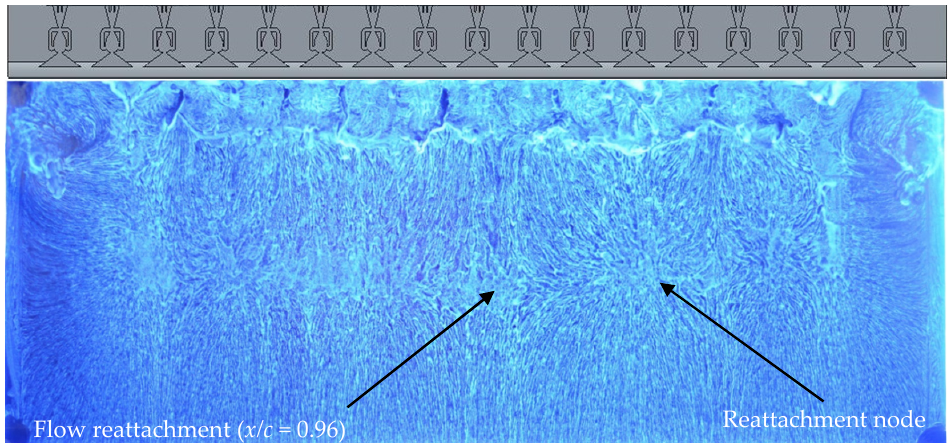
Flow reattachment ( x/c = 0.96) Reattachment node Figure 6. Surface oilflow visualization for the fluidic oscillator flow control case with C µ = 0.11%.